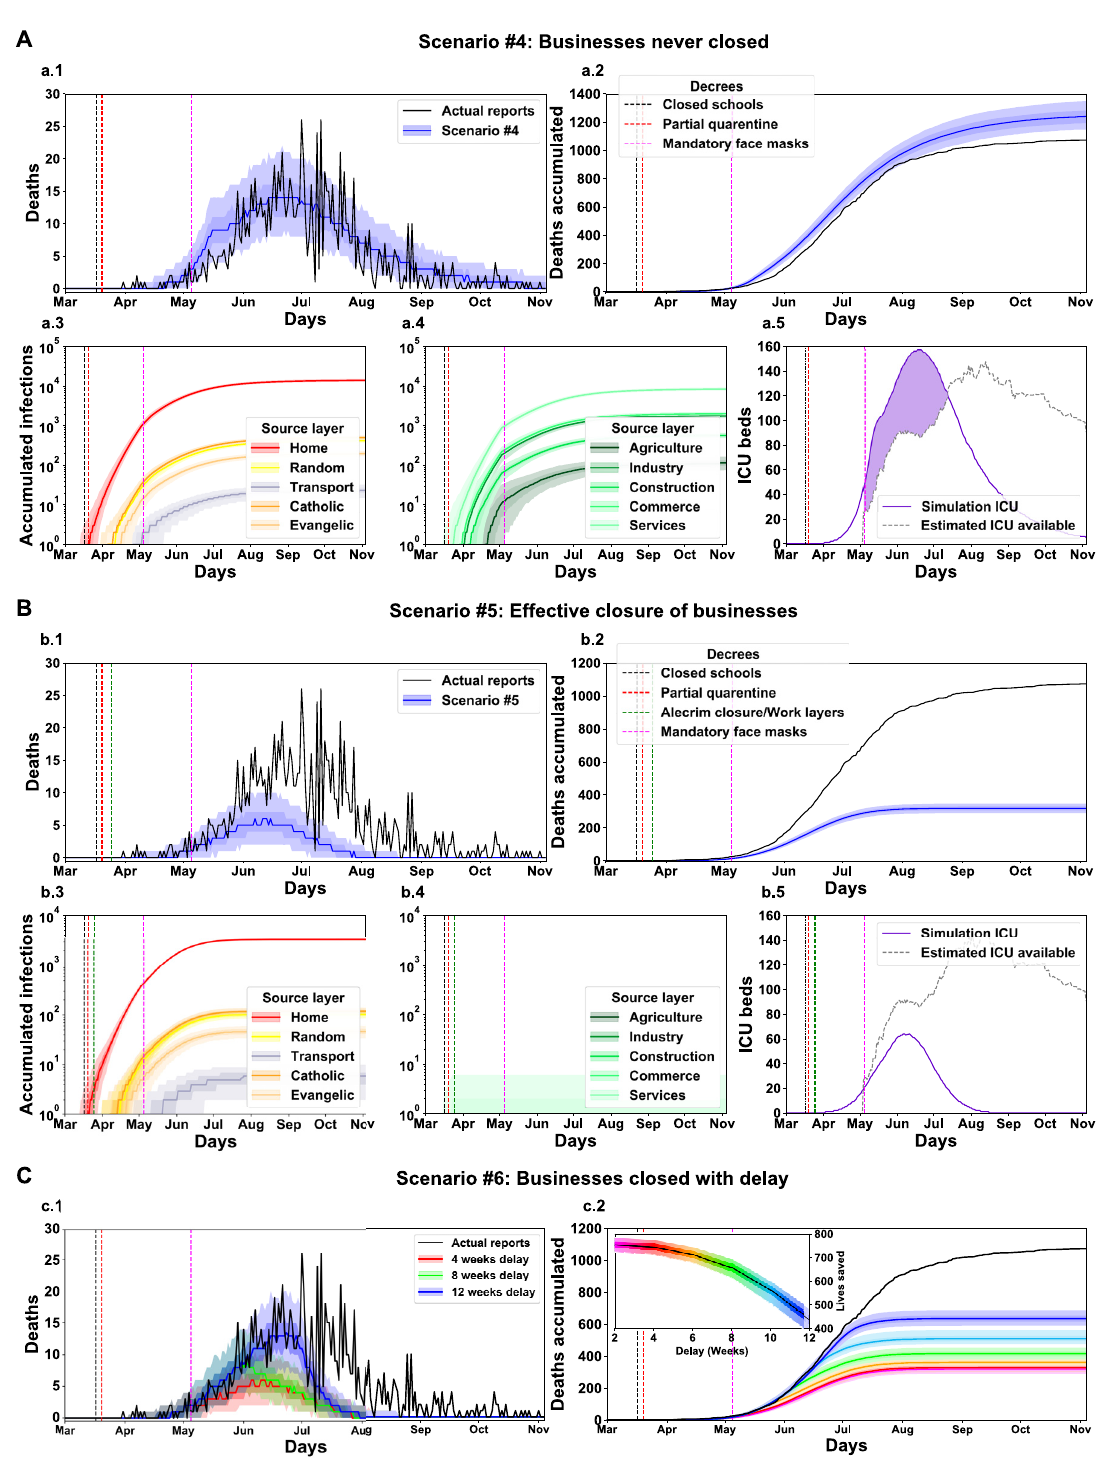
Fig 7. Simulation of different scenarios reveals a moderate and sub-optimal impact of the business closure decree on March 25th, 2020. Results for a baseline scenario altered for the condition that workplaces were never closed (#4, A), closed effectively (#5, B) and closed effectively with a delay from the original decree’s publication date (#6, C). The total number of lives saved in each scenario is the difference between the reported number of deaths and the simulation outcome. For scenario #6, the delay in weeks is colour-coded, and the additional number of lives saved is shown in an insert. See Fig 5 for panel